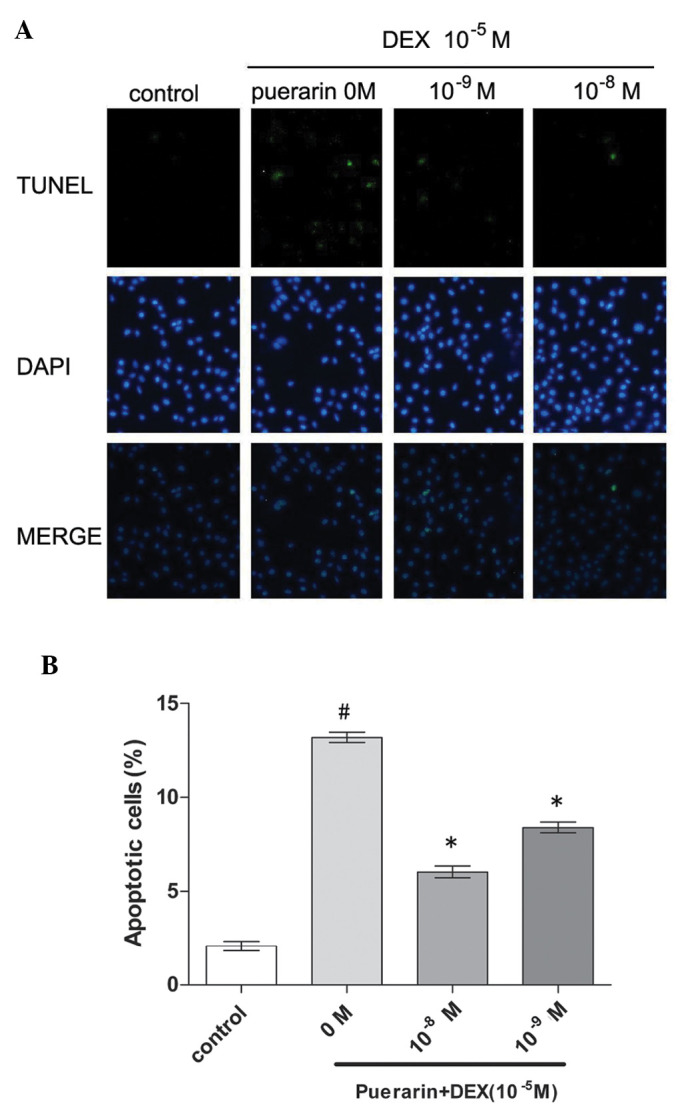
Effects of puerarin on apoptosis in hFOB1.19 cells, determined using a TUNEL assay. (A) Cells were pretreated with puerarin (0 or 10−8–10−9 M) for 3 h, and were then incubated with DEX (10−5 M) for 48 h. The number of apoptotic cells were determined using TUNEL staining and observed under a fluorescence microscope; original magnification, ×100. (B) Percentages of positive cells were calculated in six randomly selected fields as the apoptotic index using the following equation: AI = (number of positive cells/total number of cells) × 100%. Arrows indicate apoptotic cells. Data are presented as the mean ± standard deviation (n=3). *P<0.05, vs. DEX; #P<0.05, vs. control. DEX, dexamethasone; TUNEL, terminal deoxynucleotidyltransferase-mediated dUTP nick-end labeling; DAPI, 4-Diamino-2-phenylindole.